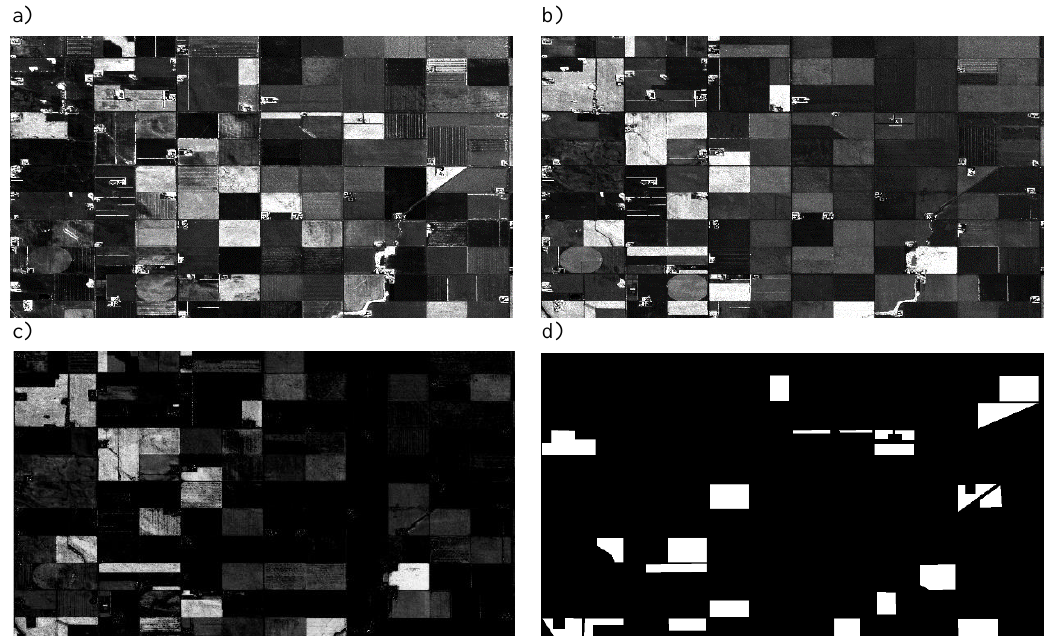
Figure 3.First Span Image (a), Second Span Image (b), Difference Image (c) Ground Truth (d).